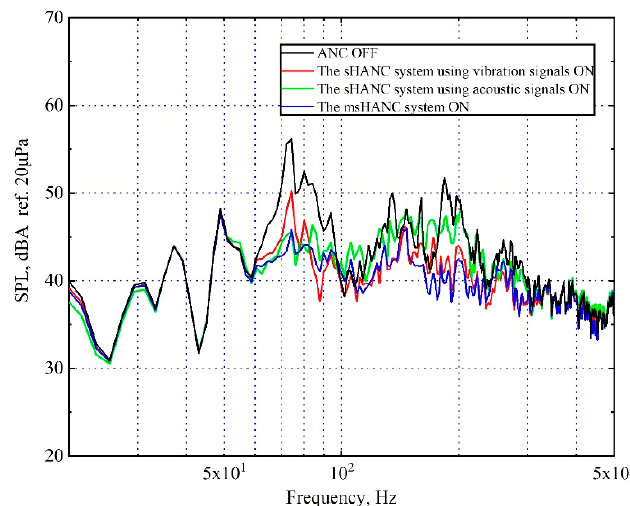
Figure 9. A-weighted averaged sound pressure level over two error microphones before and after control by sHANC system using two types of reference signals independently, the proposed msHANC system using both reference signals, when the SUV was driven at a constant speed of 80 km/h on a rough road.